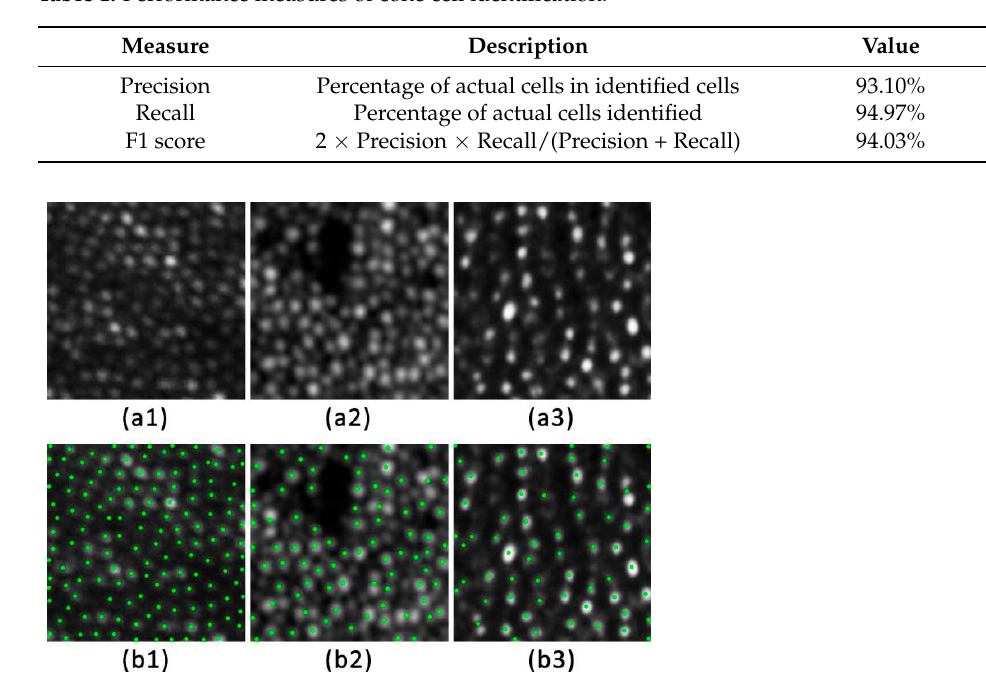
Figure 9. Cone cell identification by proposed method. ( a ) Input AO-SLO images and ( b ) corre- sponding identification results. ( 1 ) The healthy subject number 1, ( 2 ) the healthy subject number 2 and ( 3 ) the healthy subject number 3.